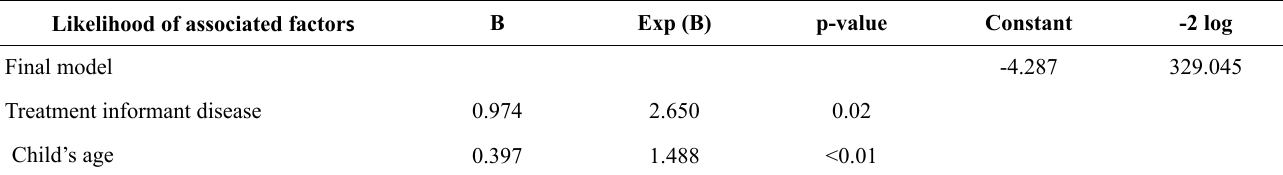
Table 3 - Final model of binary Logistic regression of factors associated with DCD by DCDQ Likelihood of associated factor